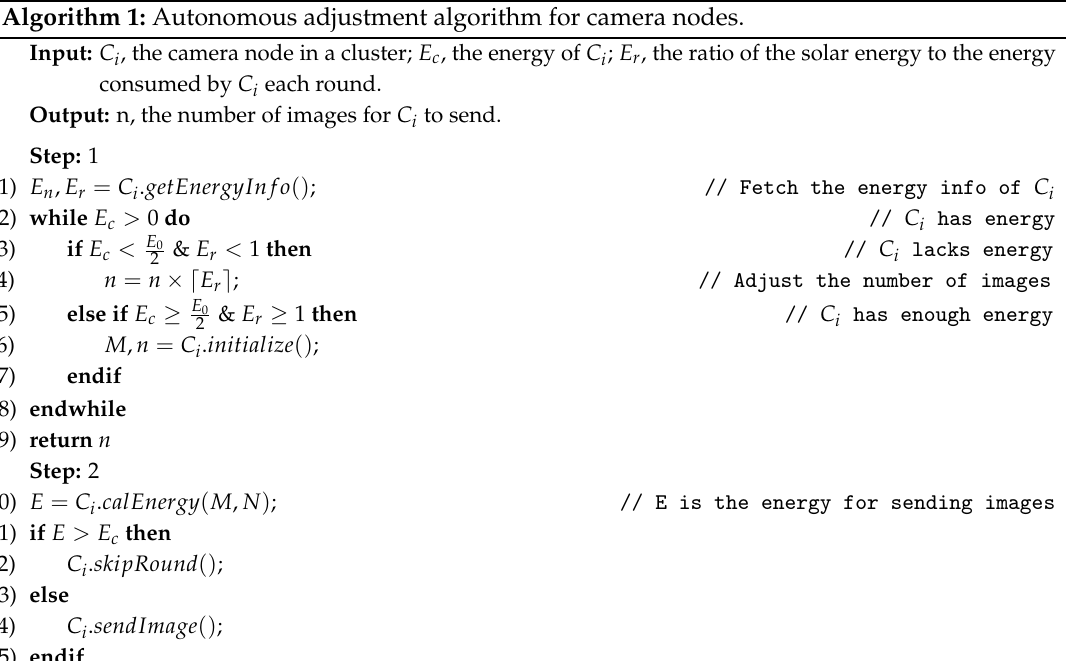
Algorithm 1: Autonomous adjustment algorithm for camera nodes.